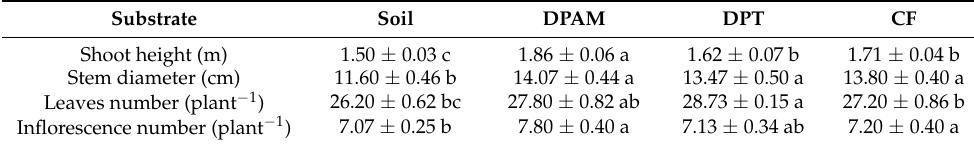
Table 1. Growth parameters of three-month-old tomato plants cultivated on different substrates. DPAM: compost of date-palm residues and animal manure; DPT: compost of date-palm trunk; CF: coconut fiber, compared with soil substrate. Numbers followed by a different letter within a line are significantly different at p ≤ 0.05, according to the least significant difference (LSD)